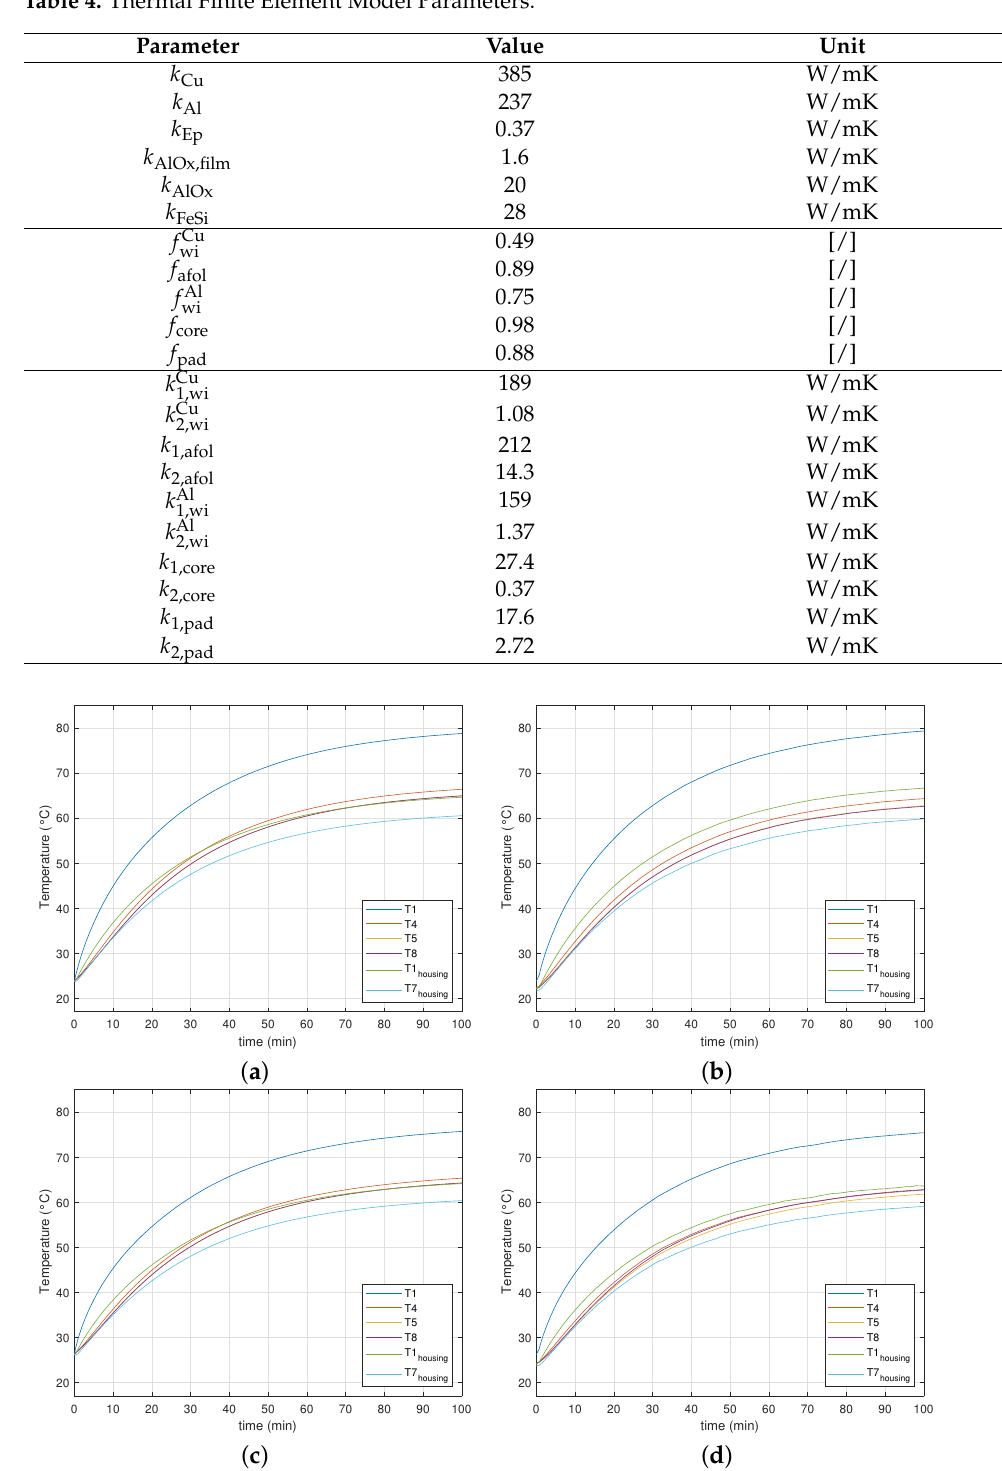
Figure 11. Transient temperature evolution at selected locations (see Figure 10) in a stator with round enamelled copper wire for a 24 slot, 22 or 26 pole combination. ( a ) Simulated tempera- tures|stator without end-winding ring. ( b ) Measured temperatures|stator without end-winding ring. ( c ) Simulated temperature|stator with end-winding ring. ( d ) Measured temperatures|stator with end-winding